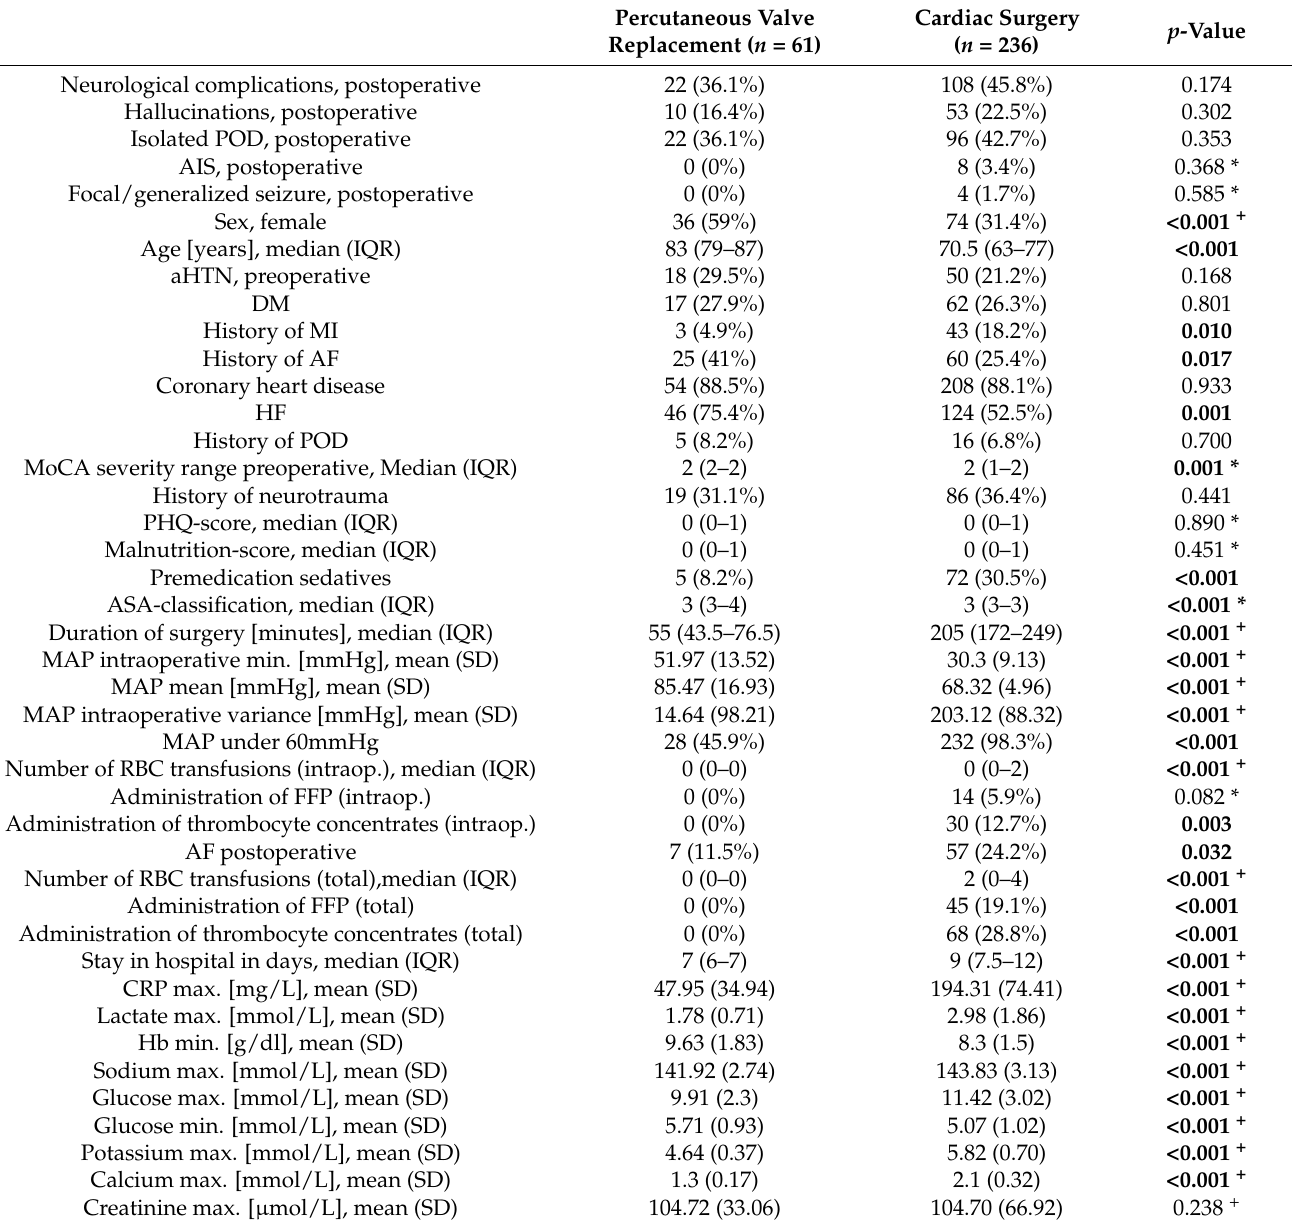
Table A2. Clinical characteristics in patients with percutaneous valve replacement and cardiac surgery. Percutaneous